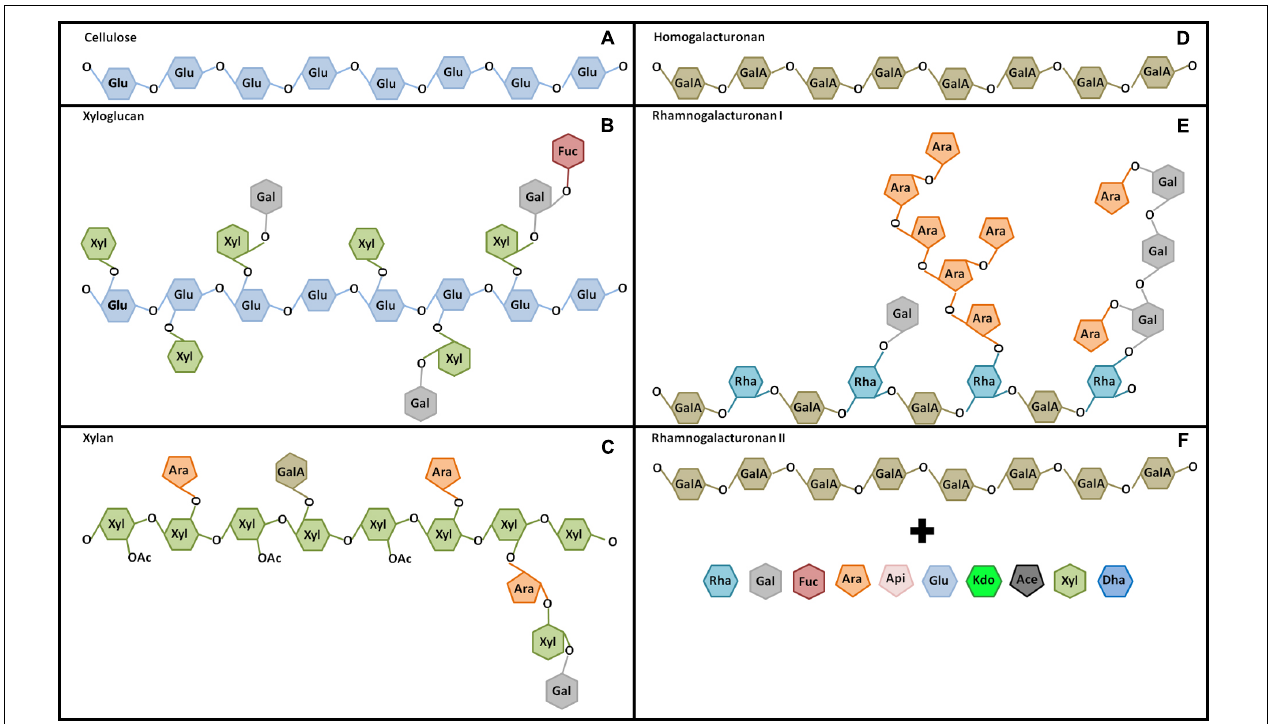
FIGURE 2 | The major cell wall polymers. (A) Cellulose consists of long chains of β -(1 −→ 4)-linked D -glucose (Glu). (B) The hemicellulose xyloglucan consists of a Glu backbone ( β -(1 −→ 4)-linked) with Glu-(6 −→ 1)-xylose (Xyl), Glu-(6 −→ 1)-Xyl-(2 −→ 1)-galactose (Gal) or Glu-(6 −→ 1)-Xyl-(2 −→ 1)-Gal-(2 −→ 1)-fucose (Fuc) side-chains. (C) The hemicellulose xylan consists of a β -(1 −→ 4)-linked Xyl backbone with arabinose (Ara), galacturonic acid (GalA) or Ara-(2 −→ 1)-Xyl-(2 −→ 1)-Gal chains linked to the carbon in position 2 or 3. Additionally, some Xyl are o -acetylated (OAc). (D) The pectin HG consists of α -(1 −→ 4)-linked GalA polymers. (E) The pectin RGI consists of a backbone of GalA-(4 −→ 1)-Rhamnose-(2 −→ 1)-GalA repeats with Rha-(4 −→ 1)-Gal or Rha-(4 −→ 1)-Ara side-chains of variable length. (F) The pectin RGII consists of a HG backbone with a wide variety of side-chains containing Rha, Gal, Fuc, Ara, apiose (Api), Glu, 3-deoxy- D -manno-oct-2-ulosonic acid (Kdo), O -acetyl- L -aceric acid (Ace), Xyl and 3-deoxy- D -lyxo-heptulosaric acid